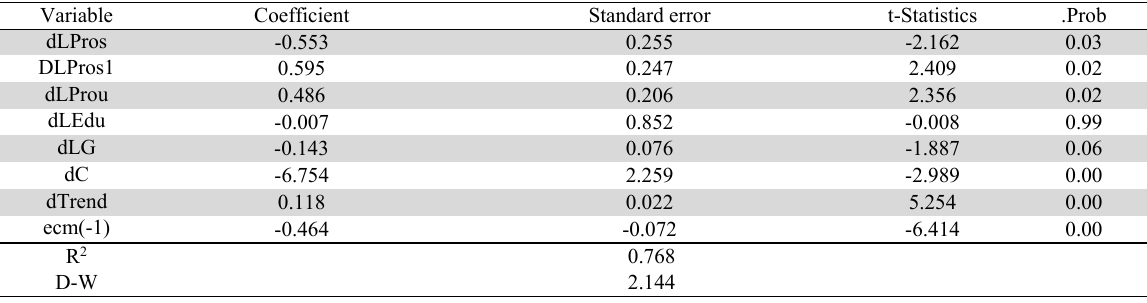
The Error Correction Mechanism with time trend Variable Coefficient